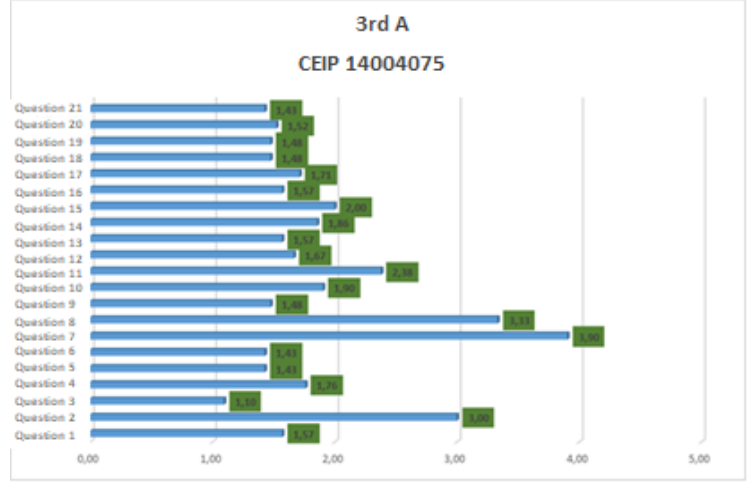
Figure 2. Average questionnaires´ results 3 rd A CEIP